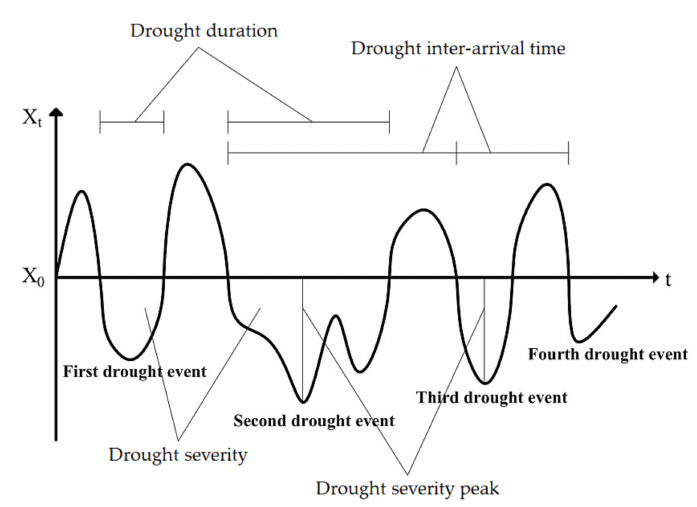
Figure 6. Drought characteristics time series.